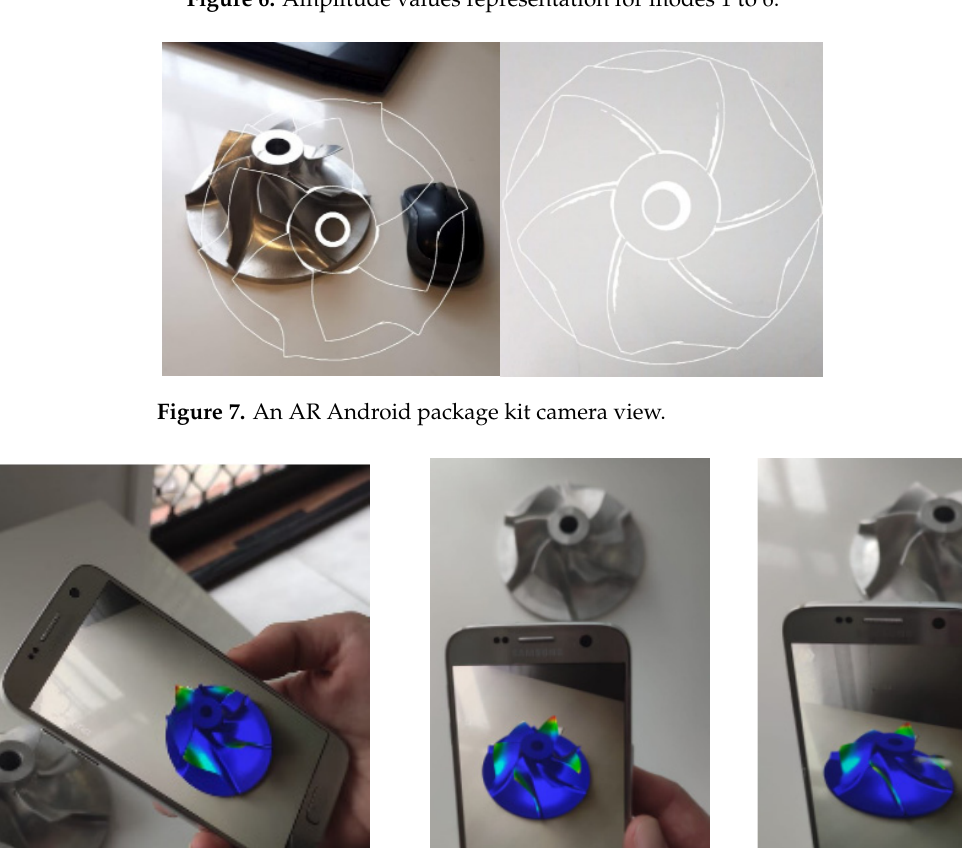
Figure 8. Modal analysis simulation results on the mobile AR visualization.